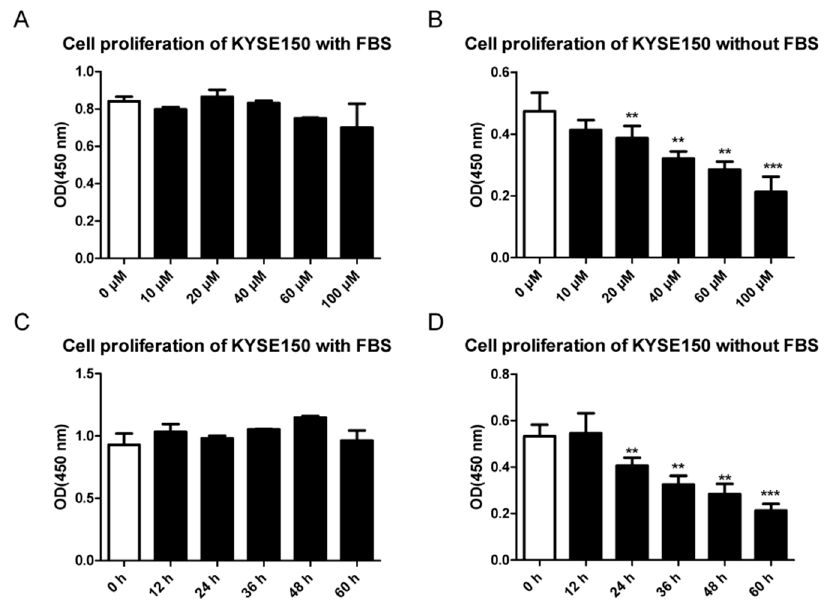
Figure 1. Cell proliferation of KYSE150 under different conditions. ( A , B ) Cells were treated with EGCG at concentrations from 0~100 µ M with ( A ) or without ( B ) FBS for 24 h. ( C , D ) Cells were treated with 60 µ M EGCG at a series of time points from 0~60 h with ( A ) or without ( B ) FBS. Data are shown as mean ± SD. n = 3, **: p < 0.01; ***: p < 0.001, ns: not significant.